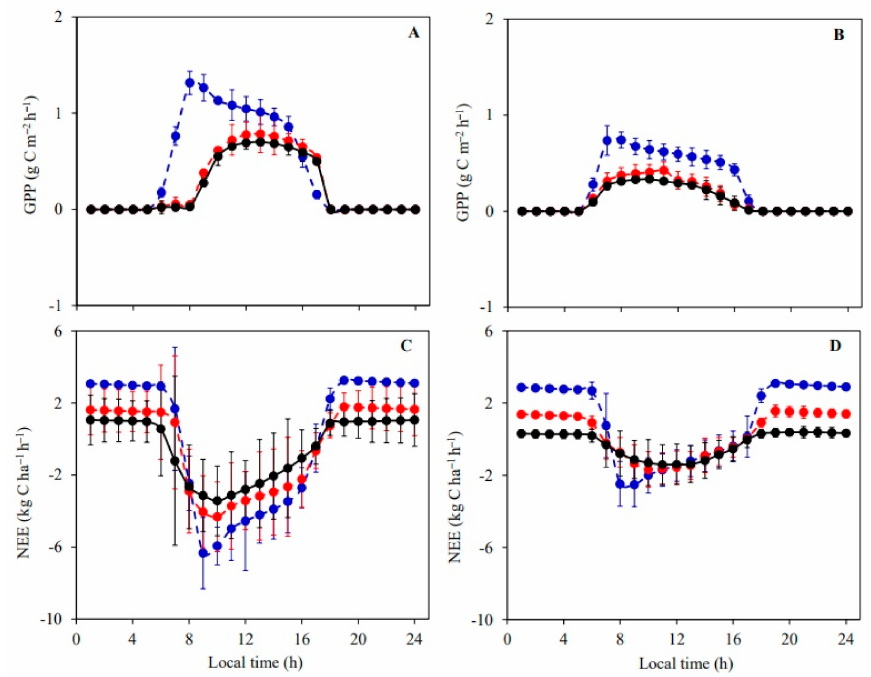
Figure 7. Simulations without calibration (dashed blue lines), simulations with calibration (dashed red lines, simulation M—wet season and simulation G—dry season) and eddy covariance observa- tions (solid black lines) of mean daily cycle of gross primary production (GPP) and net ecosystem CO 2 exchange (NEE) during the wet season ( A , C ) and dry season ( B , D ) of 2014. For details on the calibrated parameters of simulations M and G, see Table 2. Regarding NEE, carbon uptake was denoted as negative values and carbon release was denoted as positive values. For GPP, carbon uptake was denoted as positive values. Vertical bars indicate the standard deviation of